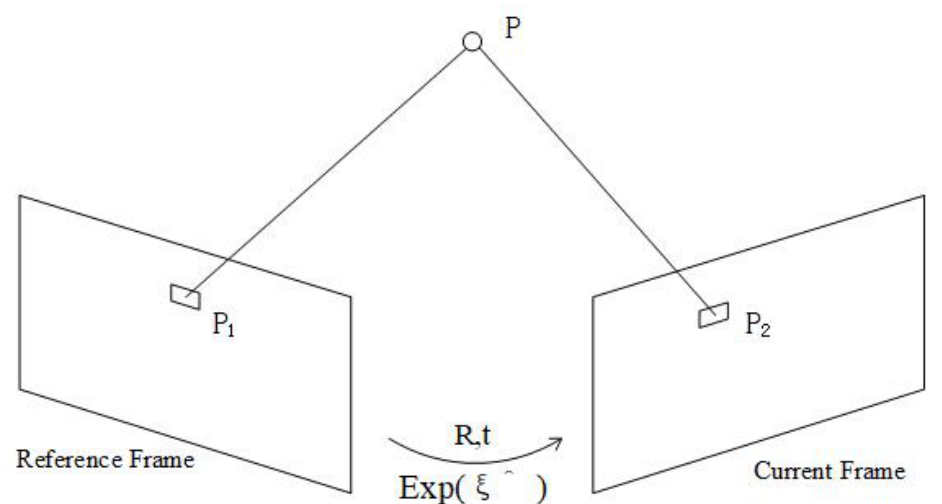
Figure 3. Direct Method. By minimizing photometric errors between the reference frame and the current frame, the poses exp ( ξ ˆ ) are constantly optimized, resulting in very fast speeds as the time for calculating the feature point descriptors is